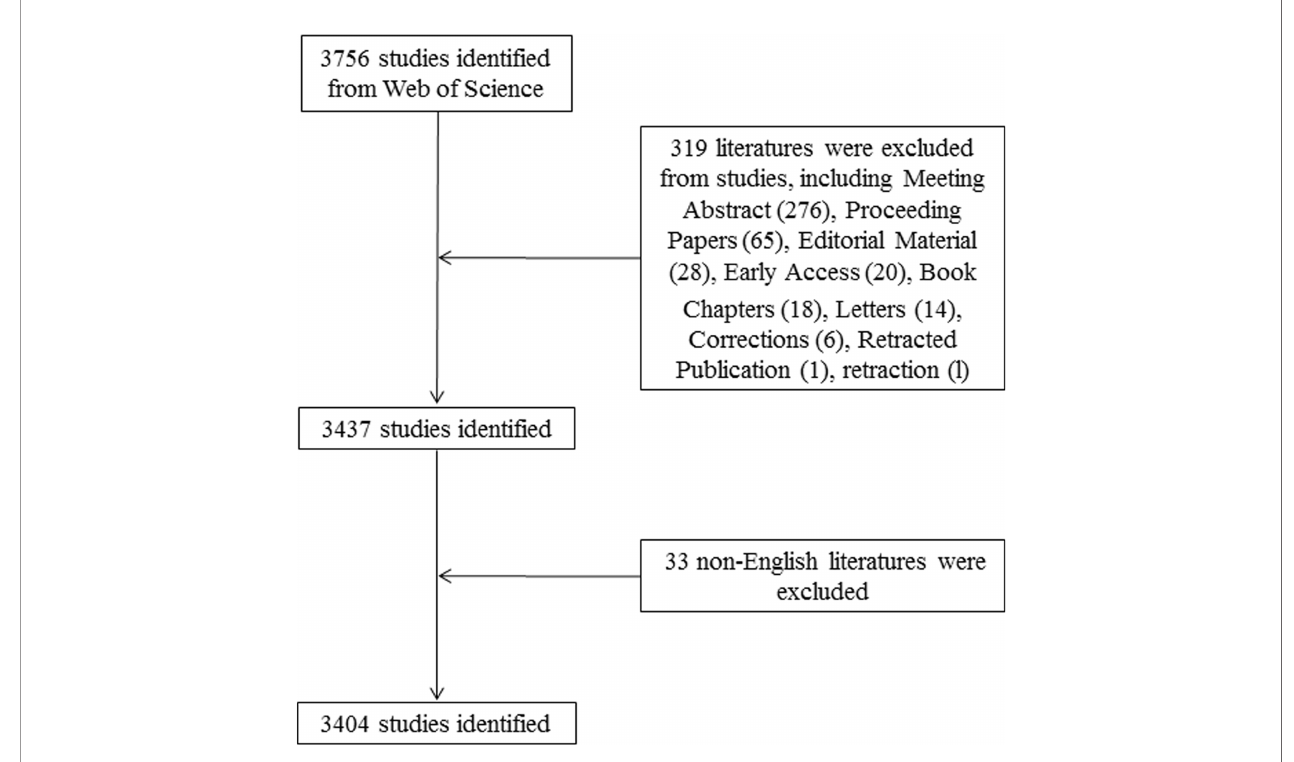
FIGURE 1 | Flowchart of the screening